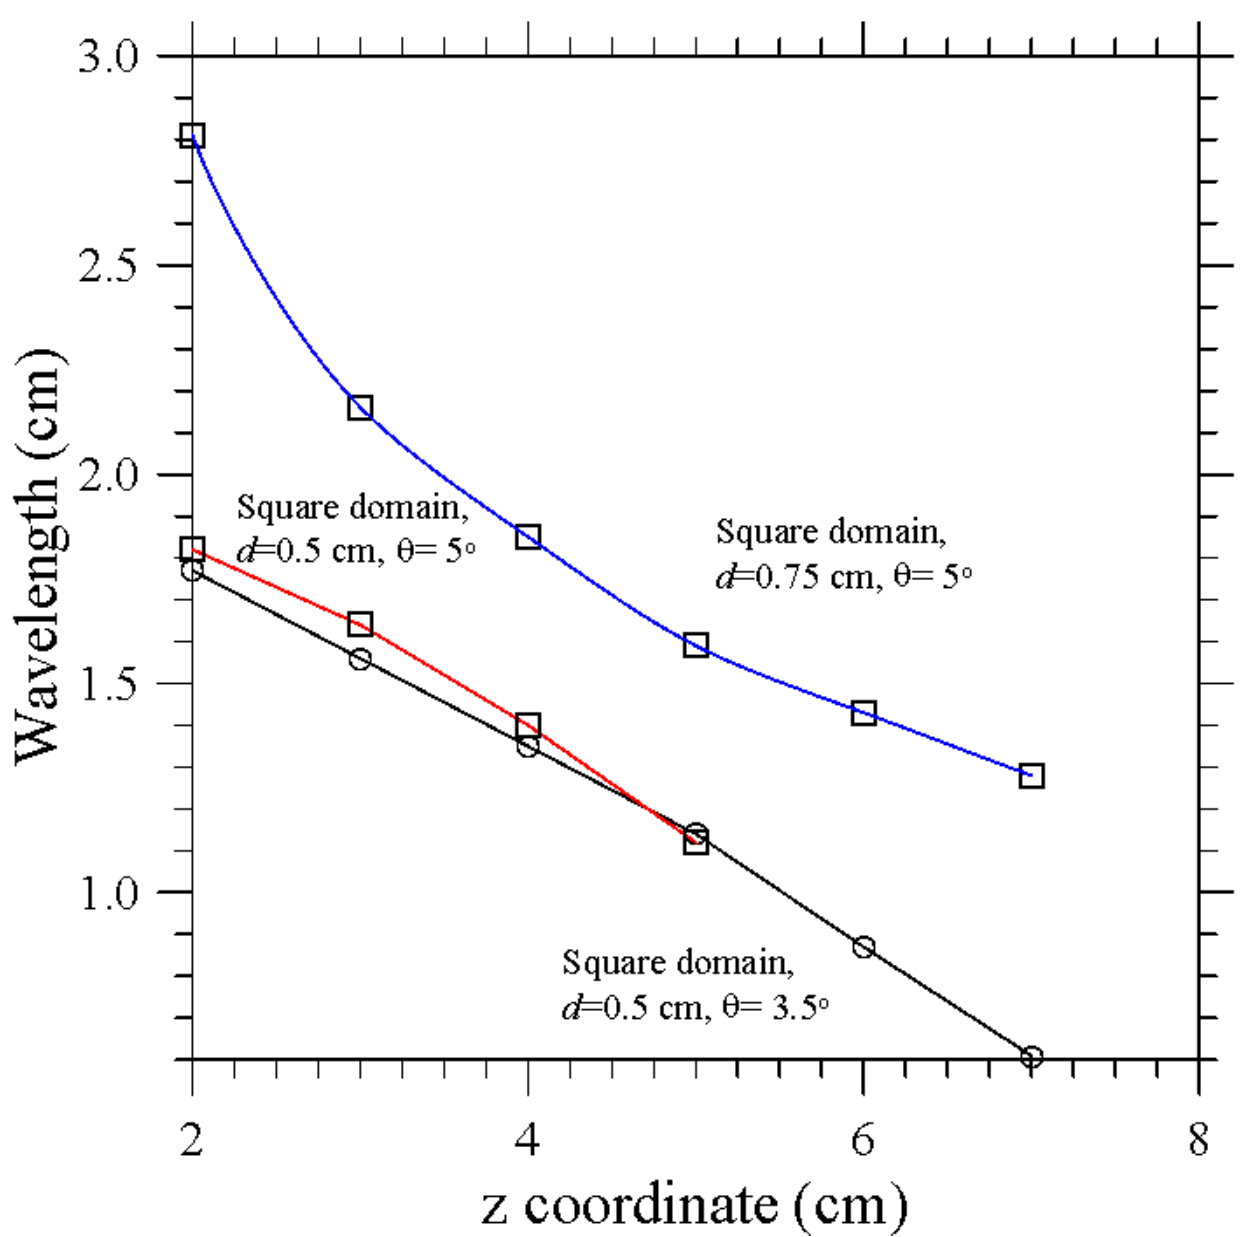
Figure 12. Profiles of temperature at different stations along the longitudinal direction z (square container, A = 10.6, d = 0.75 cm, Bo